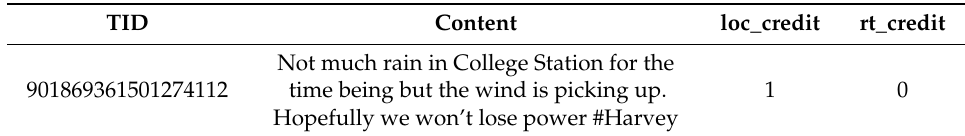
Table 4. Low-confidence